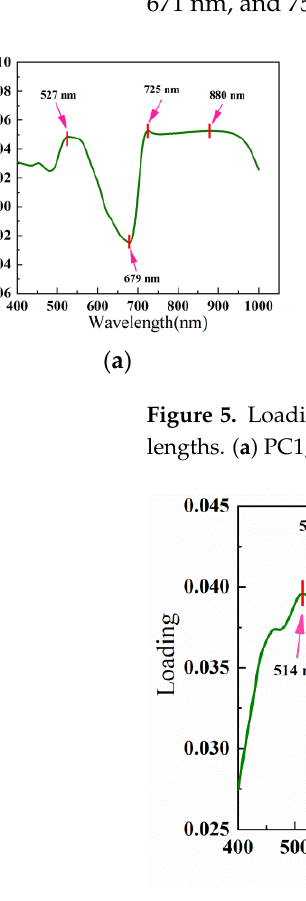
Figure 4. Scatter plot and statistical histogram of combinations between the first five principal com- ponents. PC: principal component.